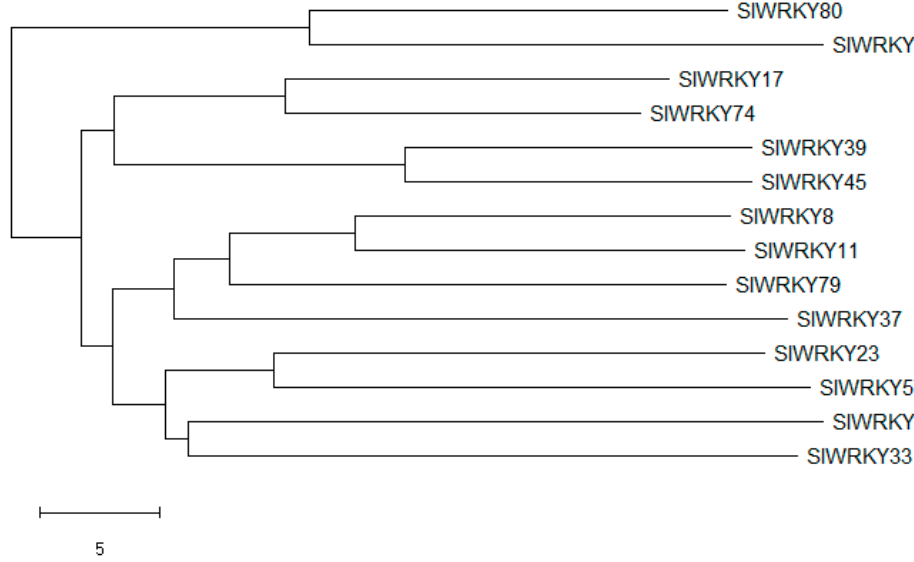
Figure 2. Phylogenetic tree of SlWRKY79, SlWRKY8, SlWRKY11, SlWRKY17, SlWRKY23, SlWRKY32, SlWRKY33, SlWRKY37, SlWRKY39, SlWRKY45, SlWRKY57, SlWRKY74, SlWRKY80, and SlWRKY81.